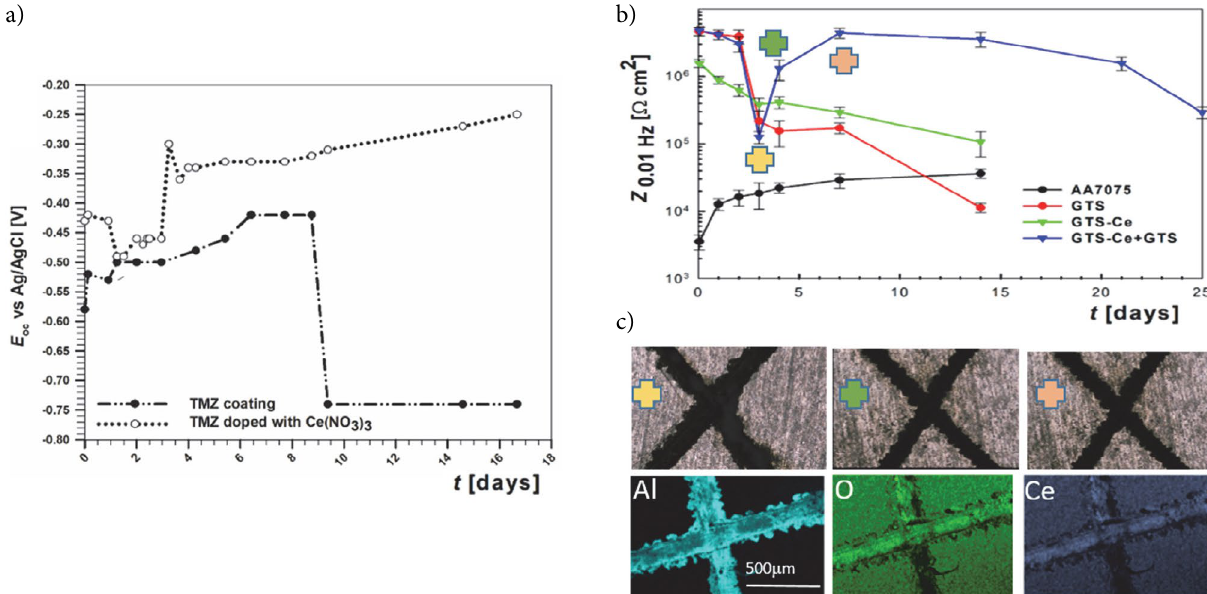
Figure 15. Electrochemical methods used to follow the self-healing of the sol-gel coating containing cerium inhibitor to assure active protection: (a) The dependence of open circuit potential ( E oc) on immersion time in 0.1 M NaCl for TMZ-3 and TMZ-3-Ce coatings. ( Reprinted from the publica- tion by P. Rodič, J. Katić, D. Korte, p.M. Desimone, M. Franko, S.M. Ceré, M. Metikoš-Huković, I. Milošev, Metals, 2018 , 8, met8040248 with permission from MDPI. 86 ) (b) Values of Z 0.01 Hz (impedance at 0.01 Hz) determined from EIS spectra for scratched uncoated AA7075-T6 and coated with GTS, GTS-Ce and GTS-Ce+GTS coating as a function of immersion time in 0.1 M NaCl. Crossed-shapes denote the time periods at which optical imag- es in (c) were taken: yellow (3 days), green (4 days) and orange (7 days). ( Reprinted from the publication by U. Tiringer, A. Durán, Y. Castro, I.